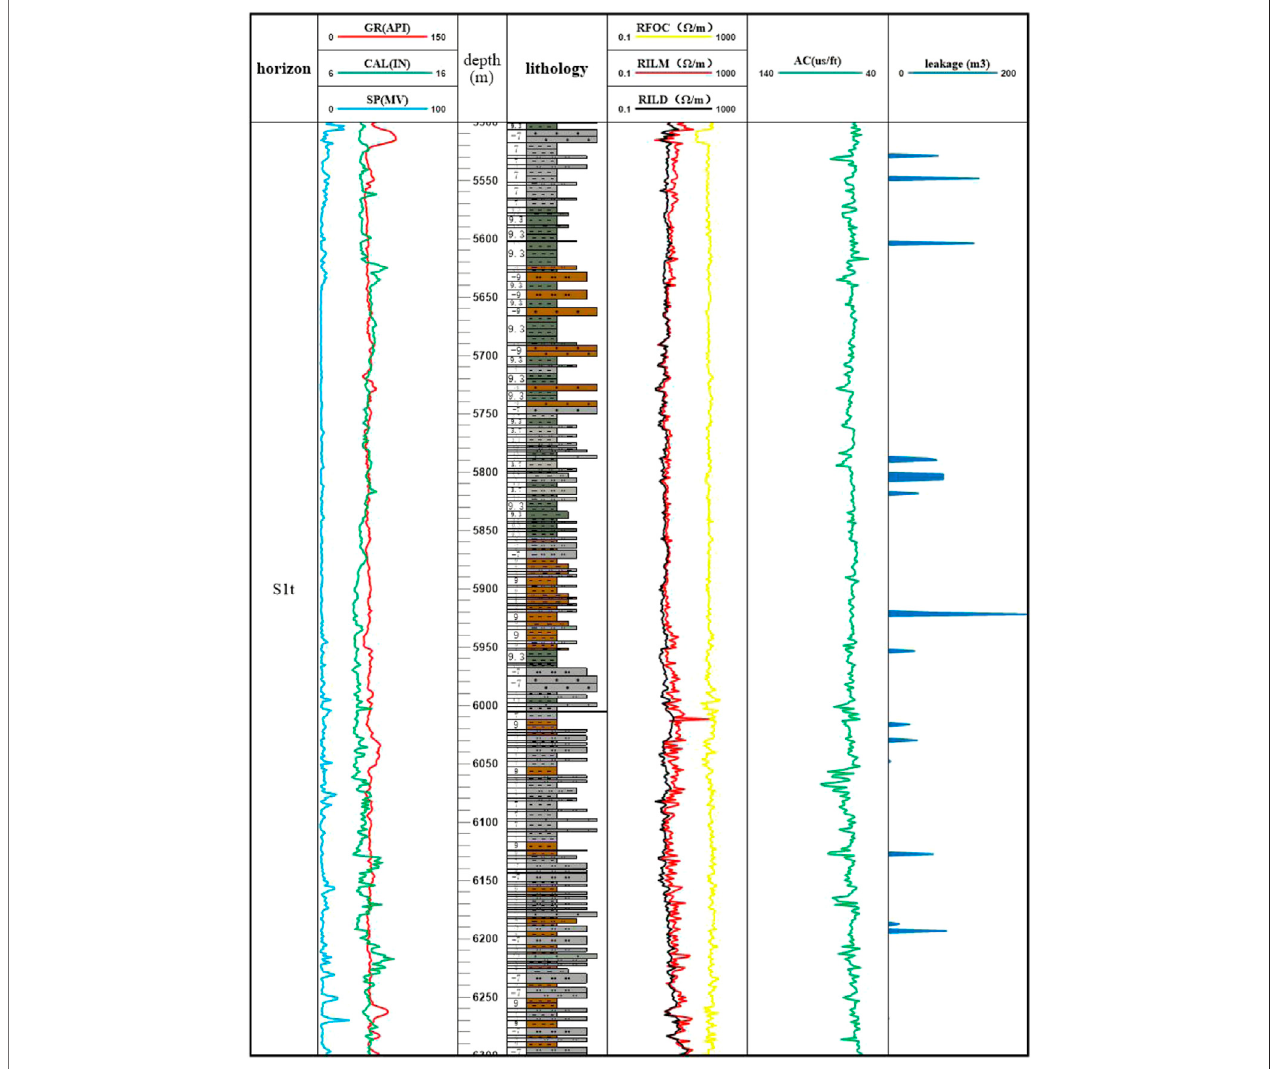
FIGURE 12 | Fracture log identi fi cation based on R/S-FD method in target layer of Well Z.